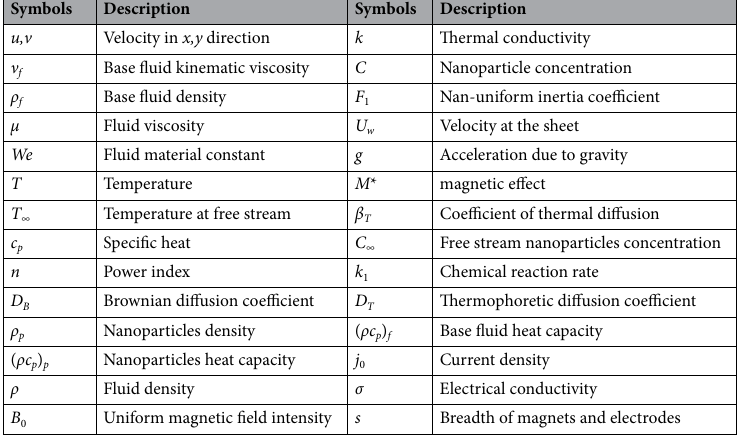
Table 1. Various symbols appear in the governing